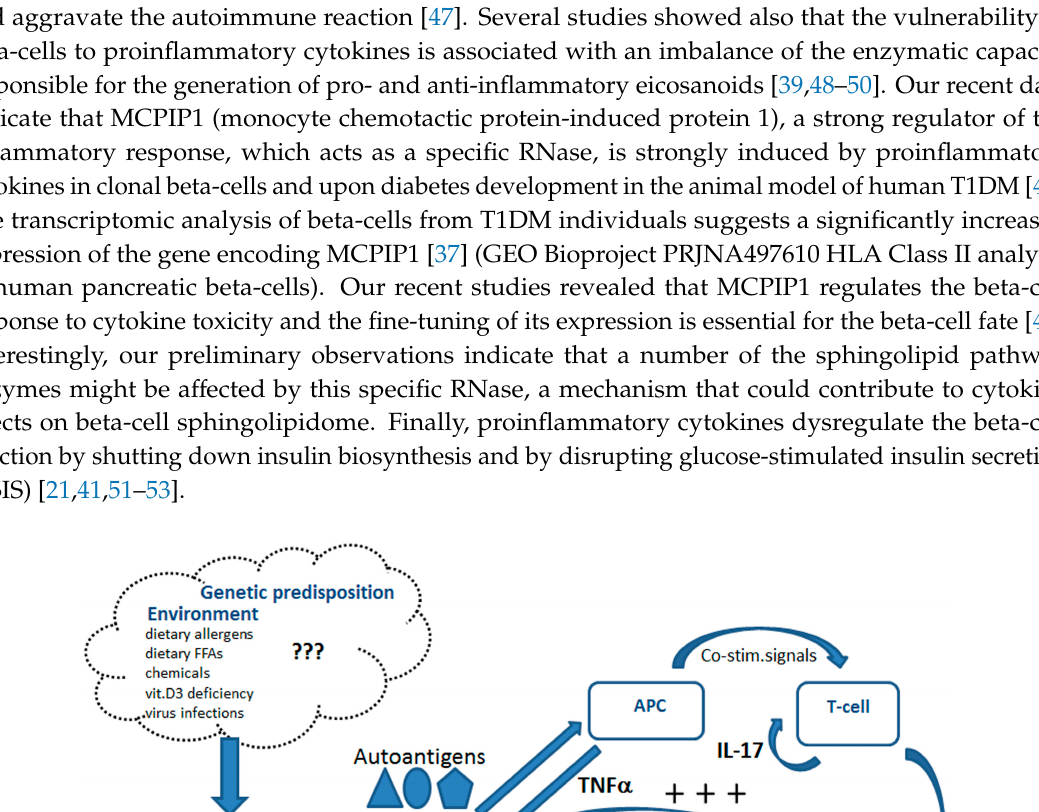
response and vulnerability of beta-cells participate in the execution of beta-cell demise during T1DM development (more details in